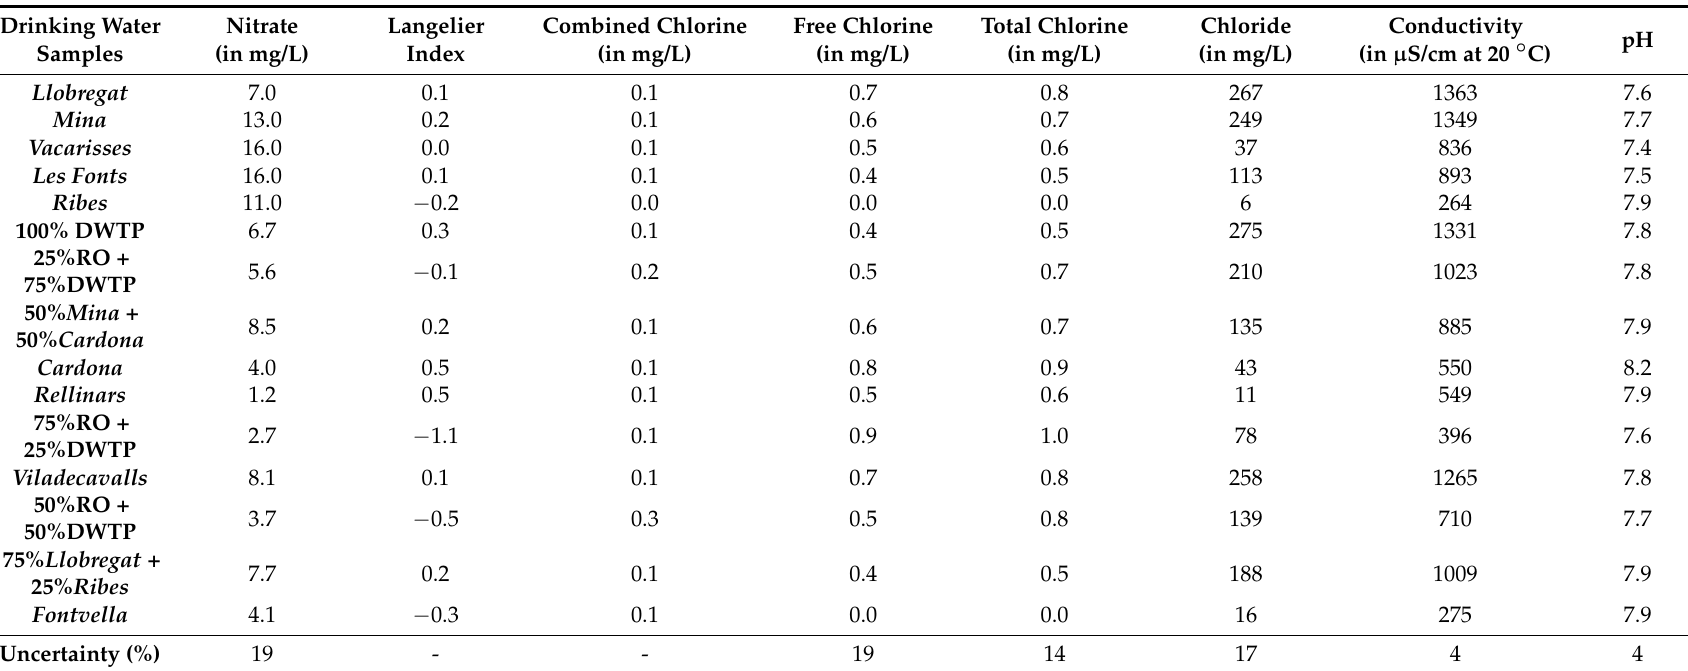
Table 3. Values and concentrations of chemical parameters determined by an accredited laboratory (Laboratori Ambiental, Mina Pu ú blica Aiguües de Terrassa, Terrassa, Spain) using standard methods for the 15 drinking water